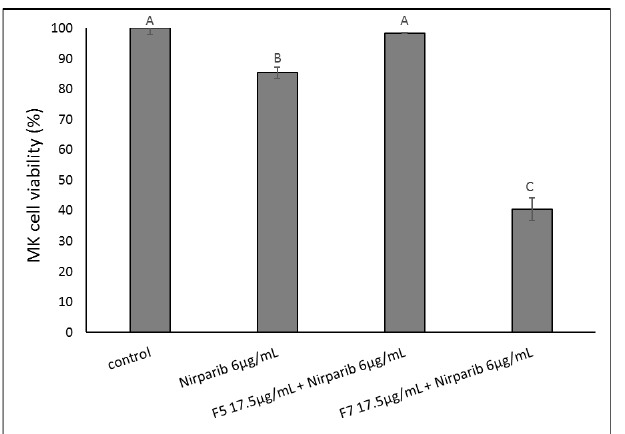
Figure 12. Cell viability of MK cells following treatment with niraparib, niraparib+F5 or niraparib+F7. Cell viability was determined by XTT assay at 48 h as a function of live cell number. Control was vehicle control (1.00% v/v methanol + 0.60% v/v DMSO). Error bars indicate ± SE ( n =